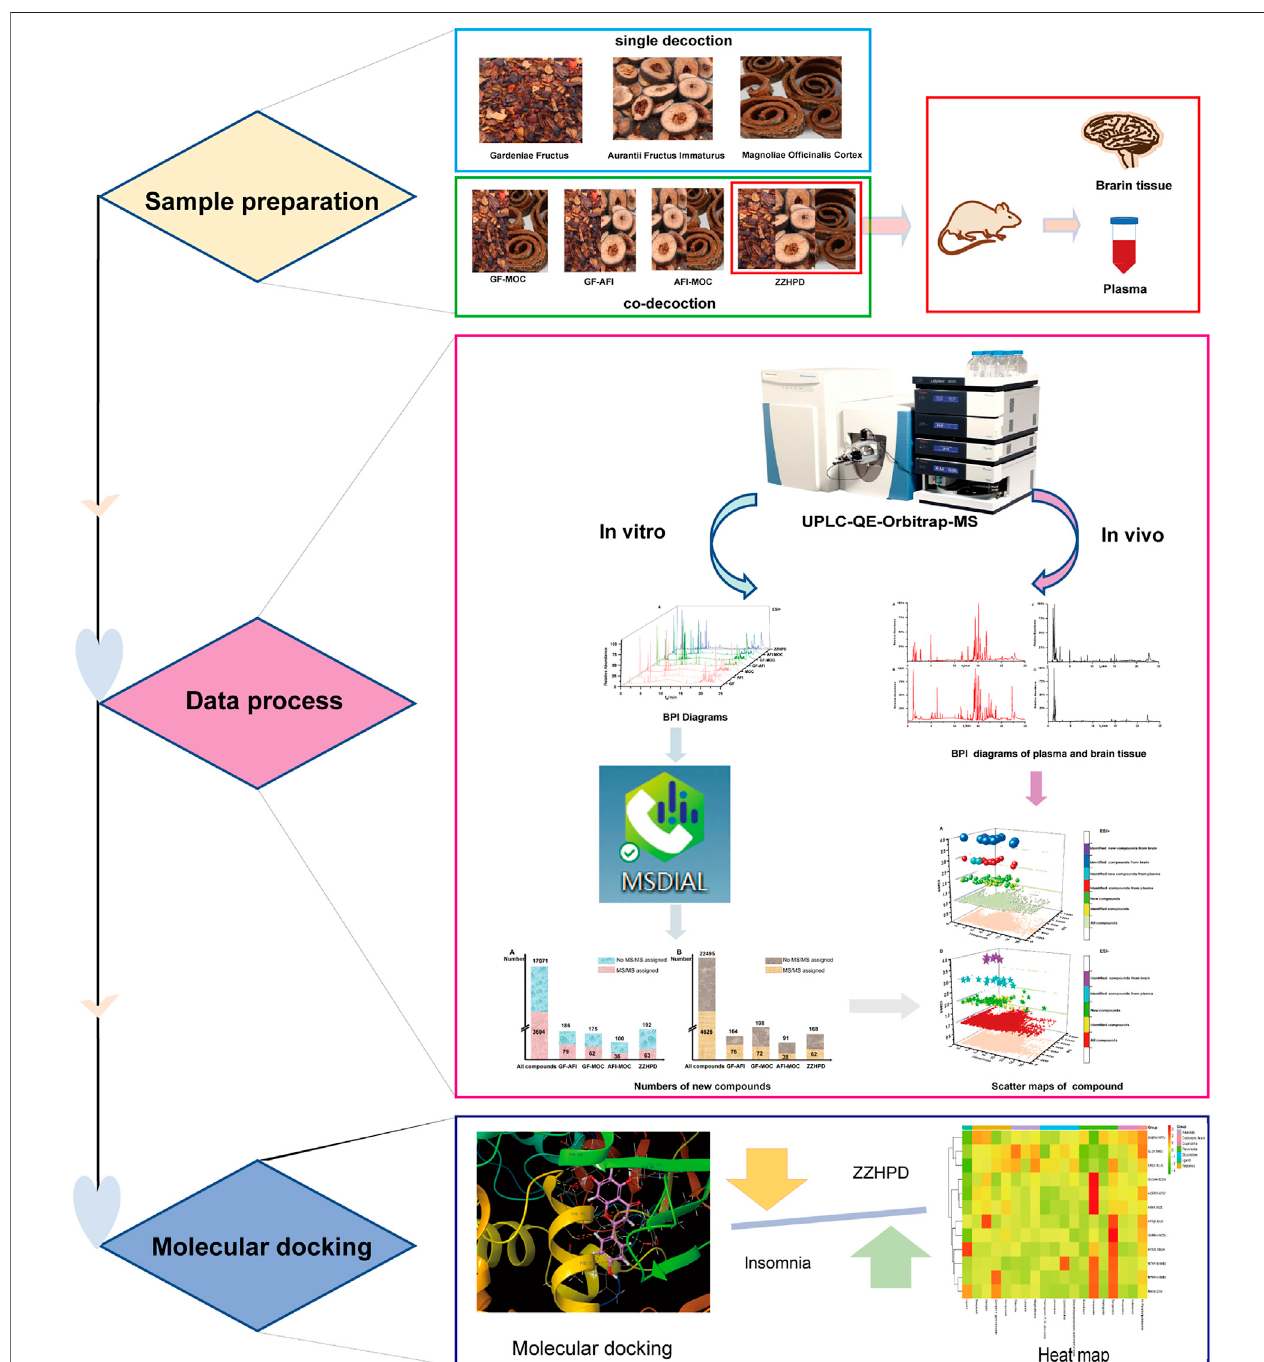
FIGURE 1 | The research fl owchart of the